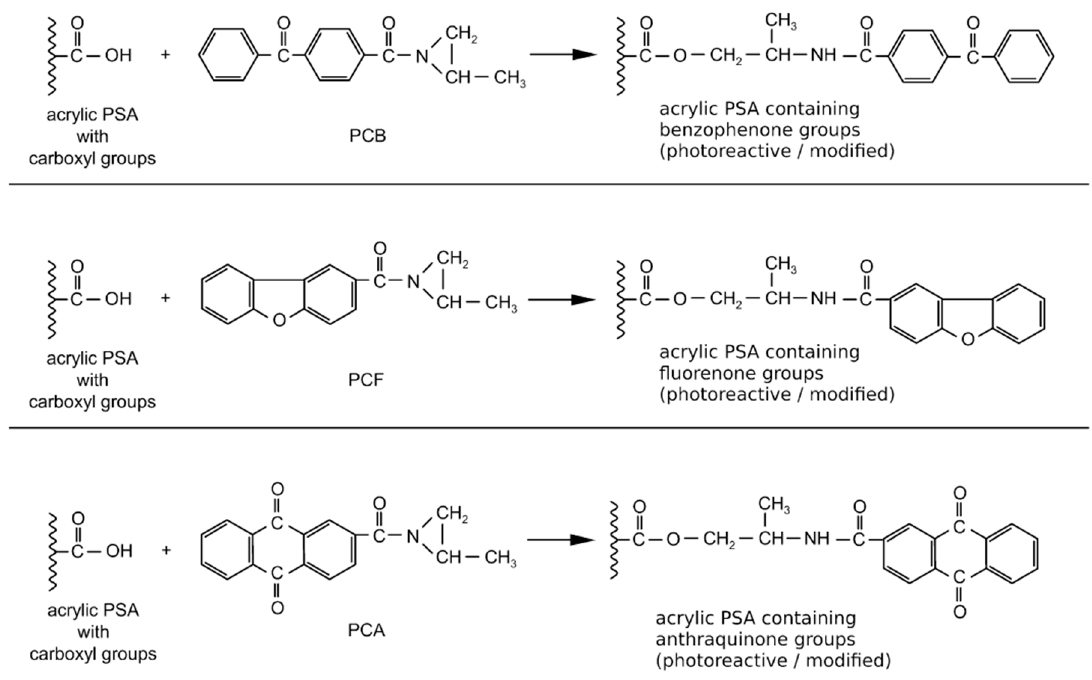
Figure 11. Reaction of additionable photoinitiator with carboxyl groups of acrylic PSA .